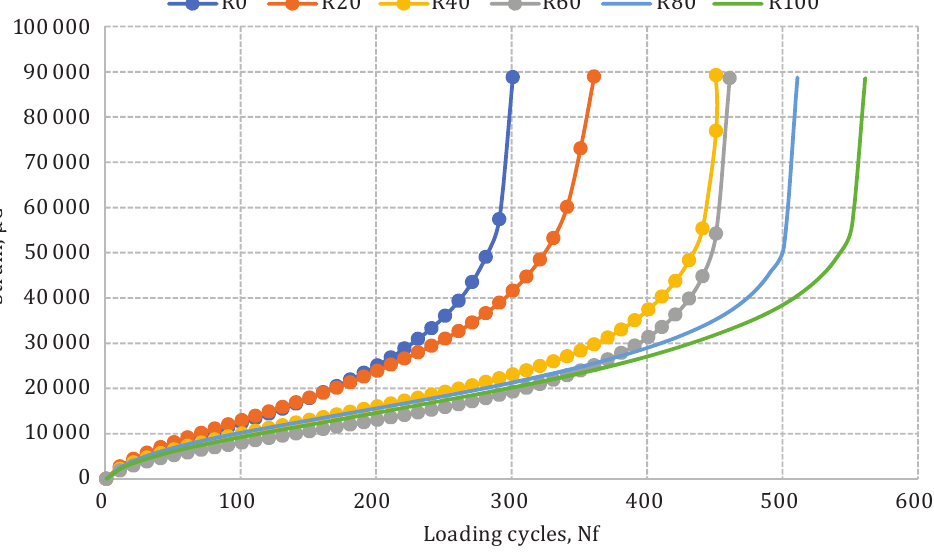
Figure 4. Fatigue loadings and strains to